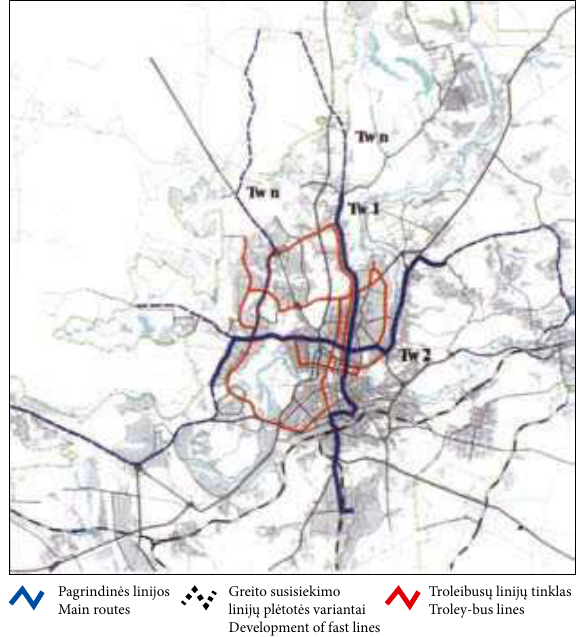
Fig. 4. Proposed tram-line routes and trolley-bus line net- work, 2002 (Juškevičius 2002)